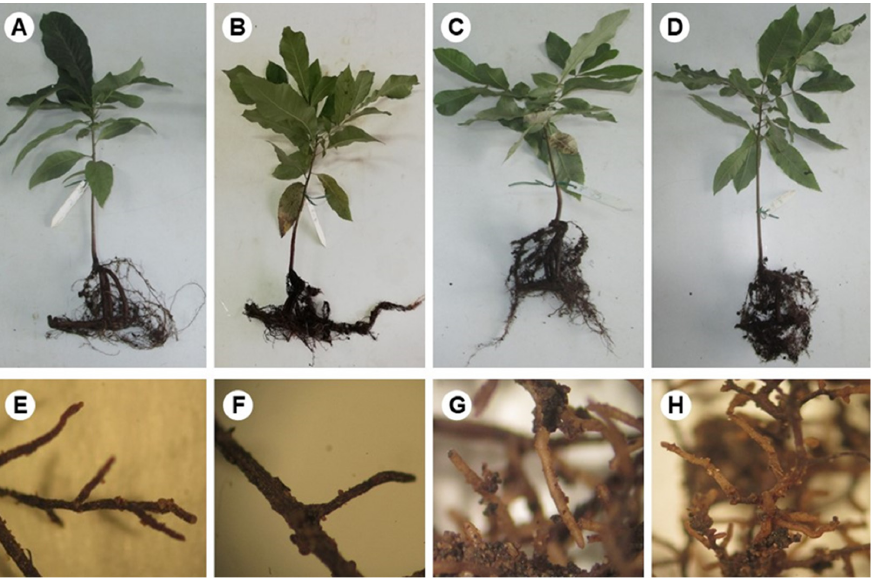
Figure 2. ‘Shoshoni’ seedlings ( A – D ) and roots ( E – H ) after six months of treatments with water ( A , E ), T. borchii ( B , F ), T. aestivum ( C , G ), or T. melanosporum ( D , H ). Roots magnification ( E – H ) 80×.